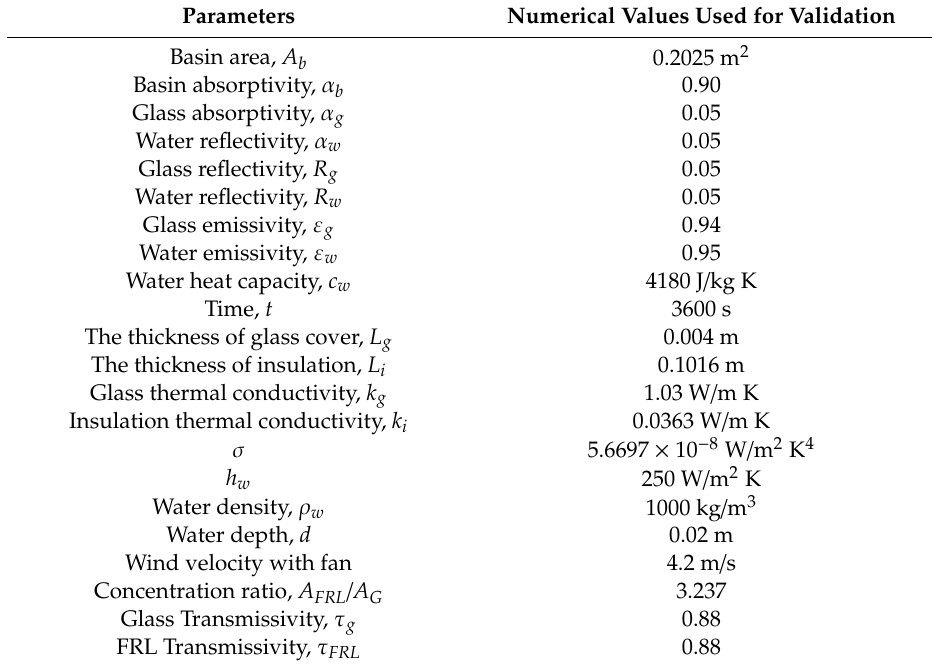
Table 4. Parameters used for validating the experiments.